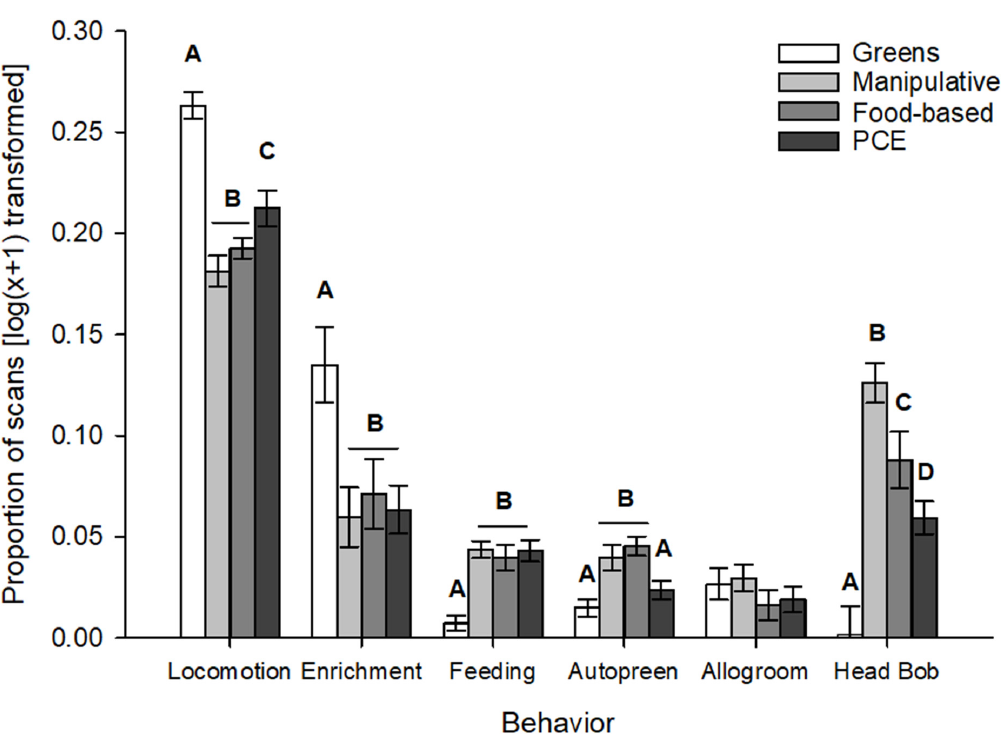
Figure 3. Differences in behaviors based on enrichment category in post-enrichment addition periods. Letters indicate groupings of categories with significantly different responses for the listed be- havior.